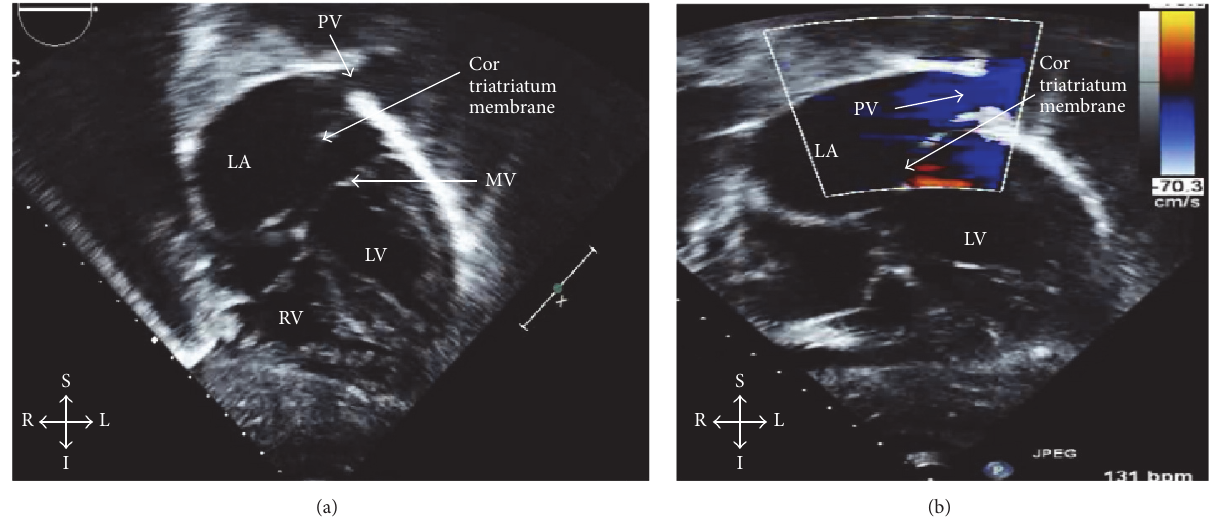
Figure 2: Subcostal coronal view on echocardiogram (a) demonstrates cor triatriatum with a membrane separating the pulmonary veins from the left ventricle inflow and (b) is a Doppler image demonstrating restricted flow through the opening of the cor triatriatum membrane with high-velocity flow through a dilated left pulmonary vein. LV: left ventricle, RV: right ventricle, LA: left atrium, RA: right atrium, MV: mitral valve, PV: pulmonary vein, S: superior, I: inferior, R: right, and L: left.